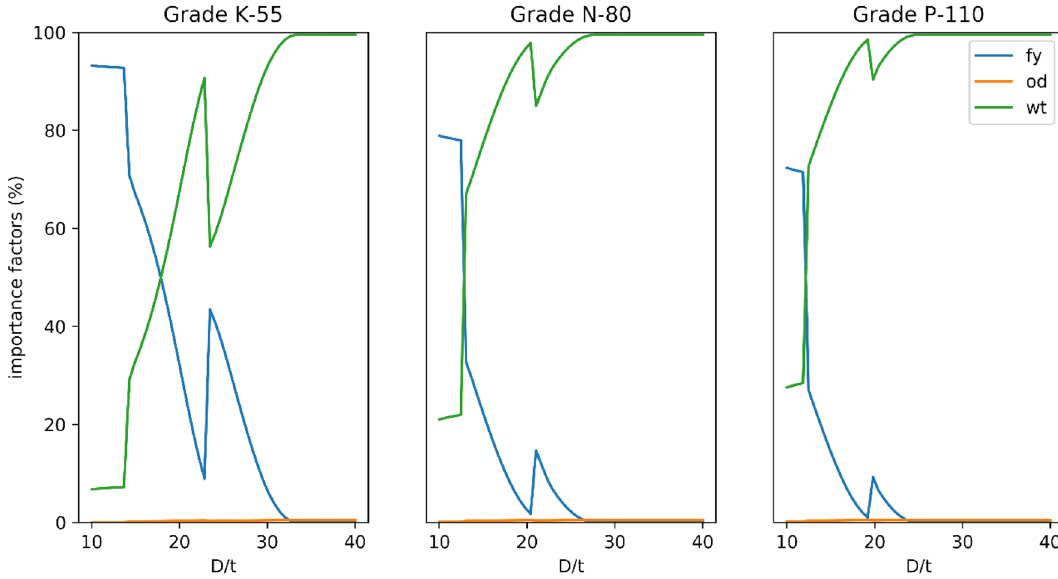
Fig. 7 Importance factors over D/t range for collapse